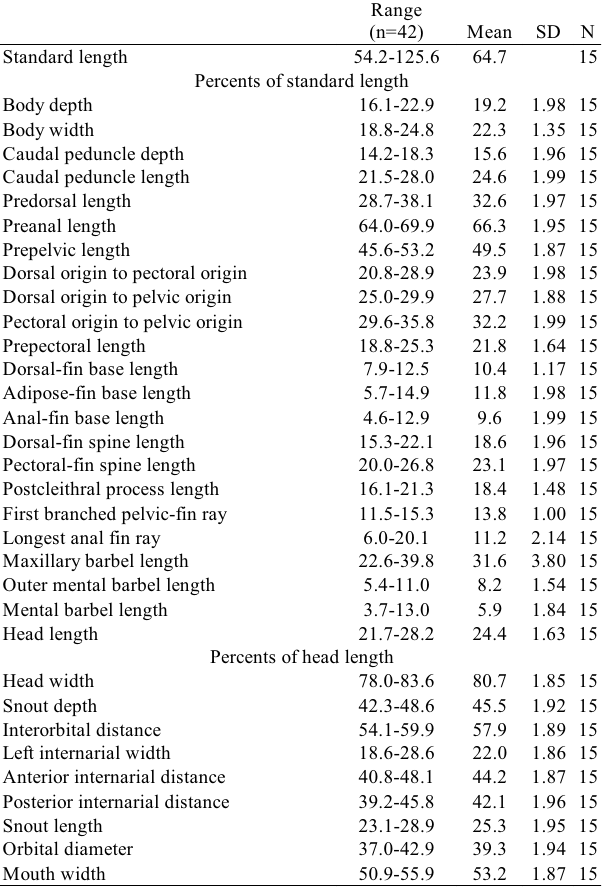
Table 7. Morphometric data for Tatia galaxias . SD = stan- dard